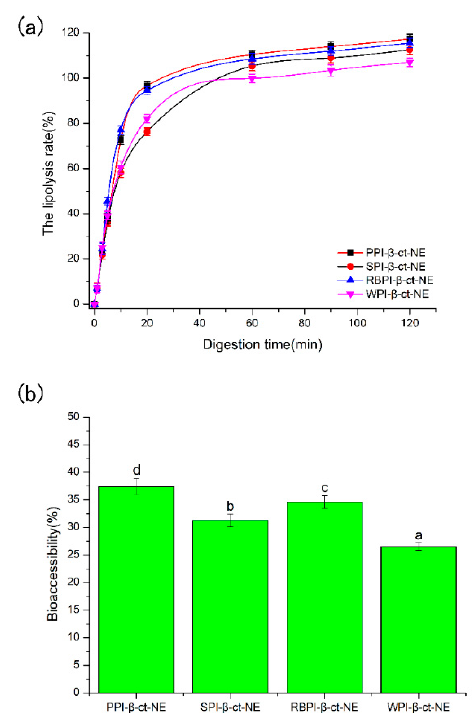
Figure 3. ( a ) The lipolysis rates of PPI-, SPI-, RBPI-, and WPI-stabilized nanoemulsions during the small intestine phase; and ( b ) the bioaccessibility of PPI-, SPI-, RBPI-, and WPI-stabilized nanoemulsions after in vitro digestion. a–d represent that there were statistically significant differences ( p < 0.05) between PPI-, SPI-, RBPI-, and WPI-stabilized nanoemulsions, in terms of bioaccessibility. The lines are for visual aid only and the error bars are based on SD.